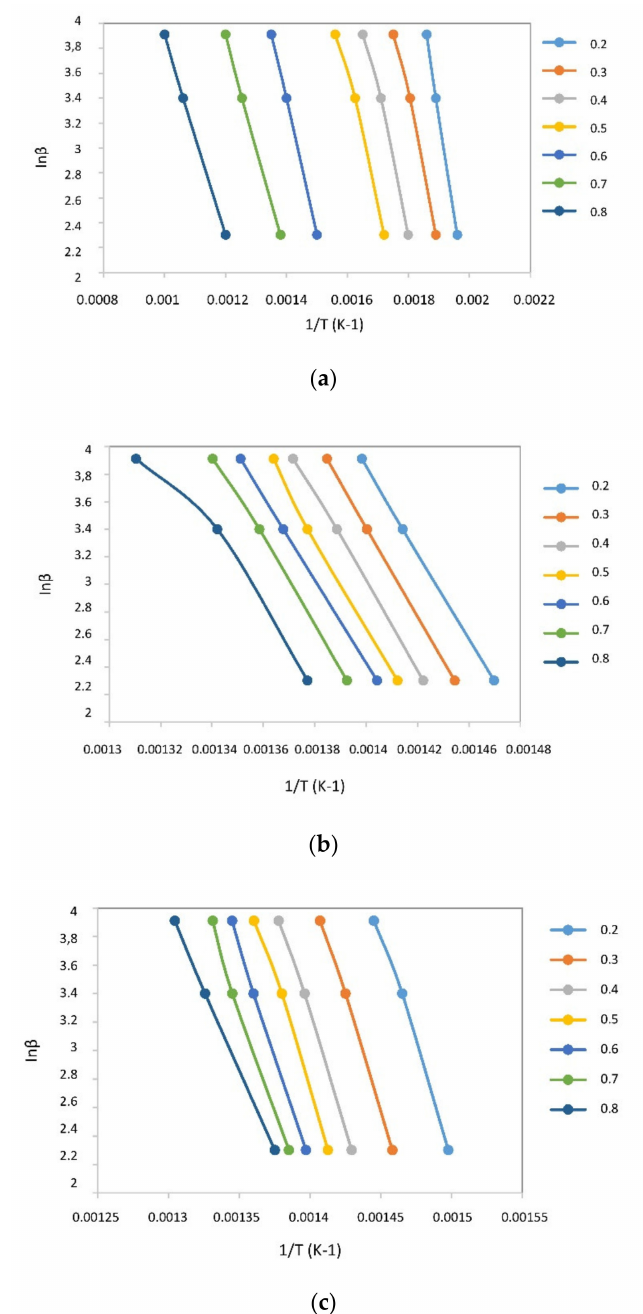
Figure 4. Linear correlation for determining activation energy of SM, PET, and their blend calculated by FWO ( a ), ( b ), ( c ),